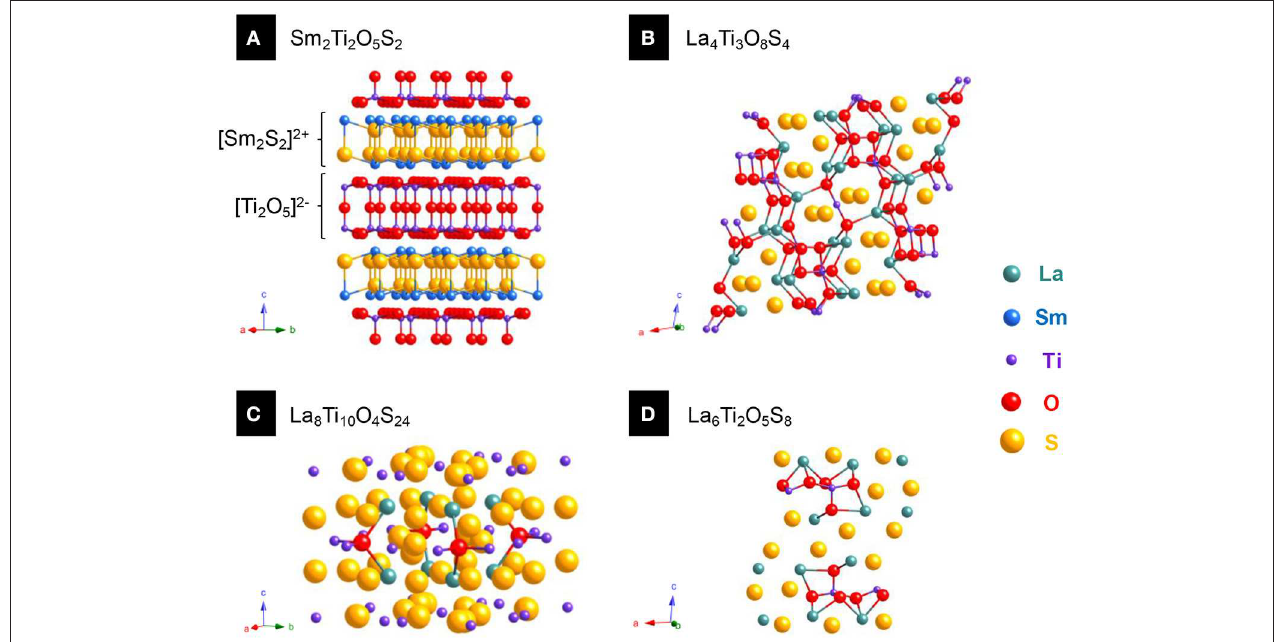
FIGURE 4 | Various quarternary oxysulfide structures containing titanium. (A) Sm 2 Ti 2 O 5 S 2 (JCPDS 13-1325) exhibits selective bonding as sulfur is preferentially bound to titanium and oxygen to samarium. (B) La 4 Ti 3 O 8 S 4 (JCPDS 09-7018), (C) La 8 Ti 10 O 4 S 24 (JCPDS 09-8085), and (D) La 6 Ti 2 O 5 S 8 (JCPDS 09-7017) show different structures with unselective